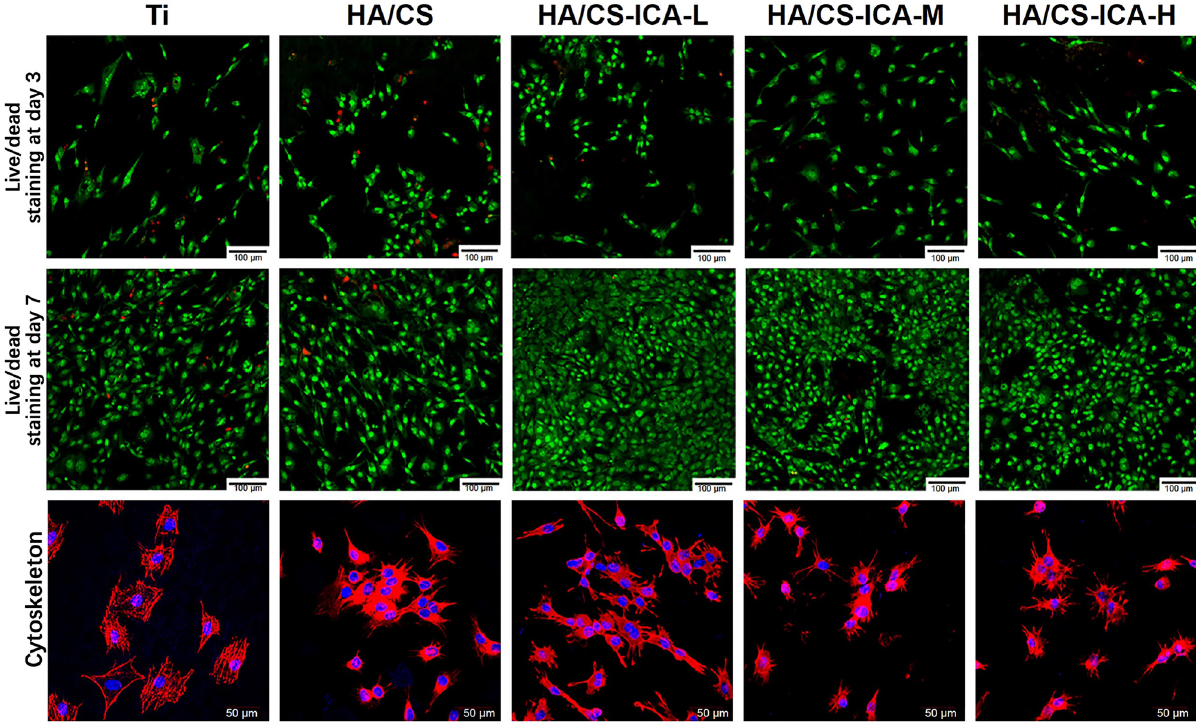
Figure 8: Live/dead and cytoskeleton staining of MC3T3 - E1 cells on di ff erent surfaces of HA/chitosan multilayer coating [ 117 ]